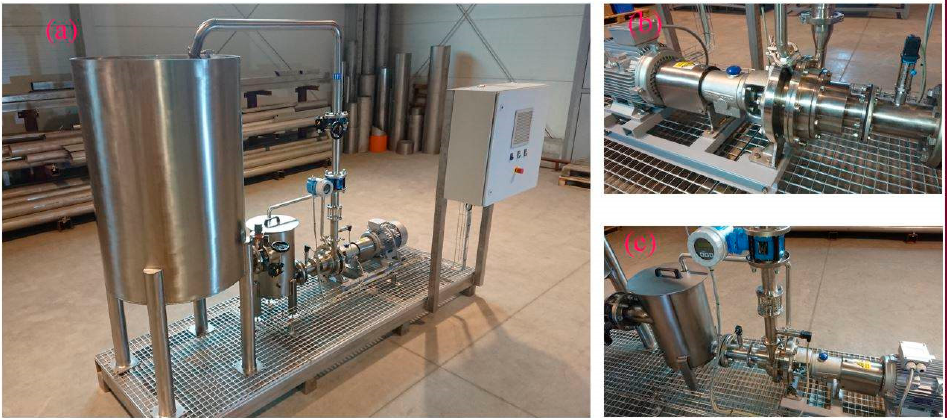
Figure 4. View of the test stand; ( a )—general vie of the stand, ( b )—pump section, ( c )—measuring devices.